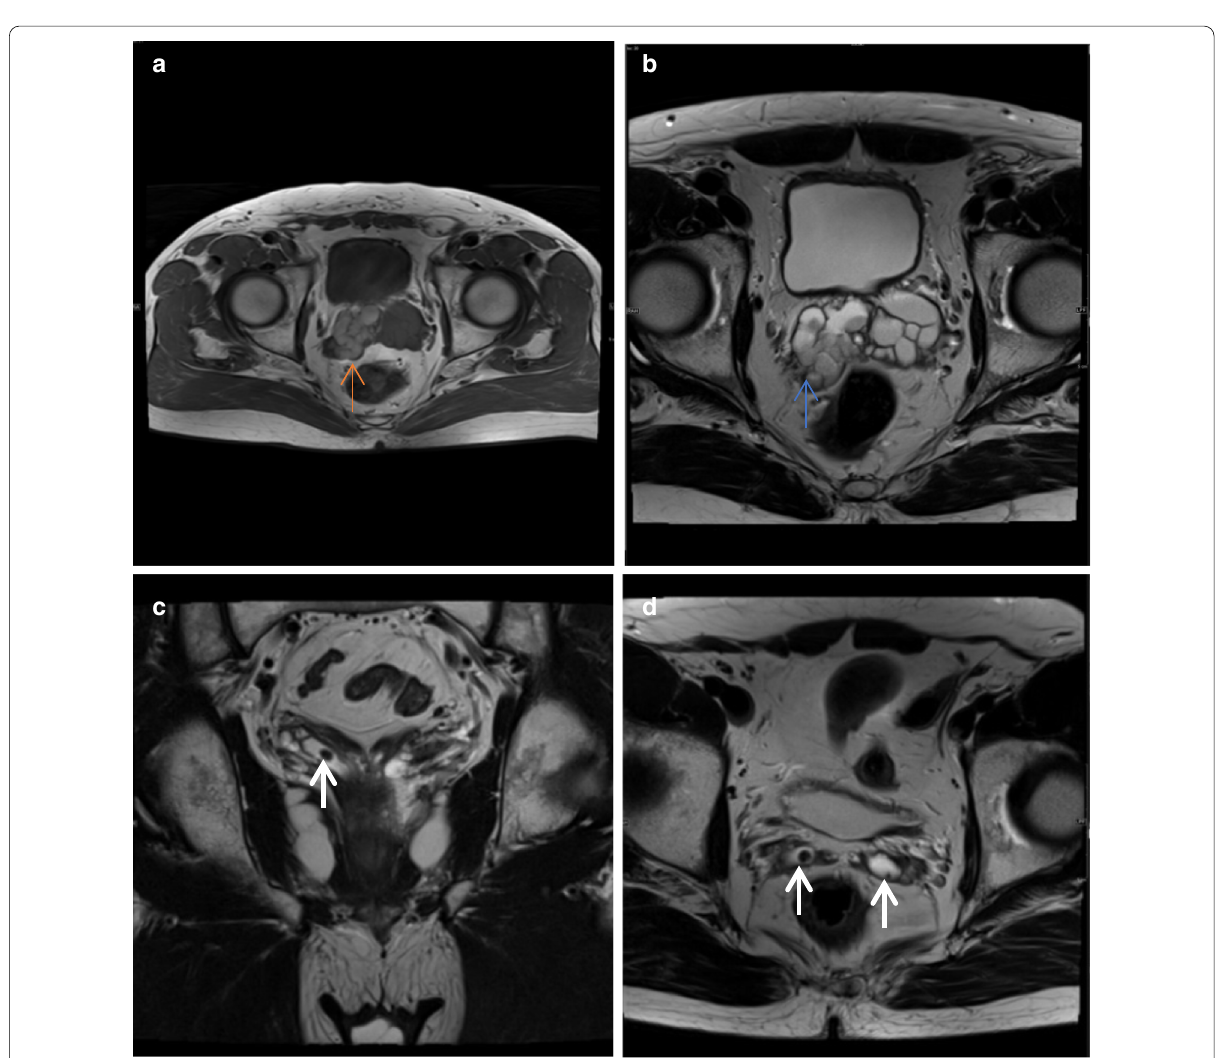
Fig. 1 Haematospermia ( a ) Axial T1W image shows intrinsic T1 hyperintensity within the right seminal vesicle (red arrow). b Axial T2W image shows corresponding T2 hypointensity in this region in keeping with blood products (blue arrow). c Coronal T2W and ( d ) axial T2W images in a different patient show rounded low T2 signal intensity lesions, in the right seminal vesicle in ( c ) and bilaterally in ( d ) but larger in the right seminal vesicle, in keeping with stones (white